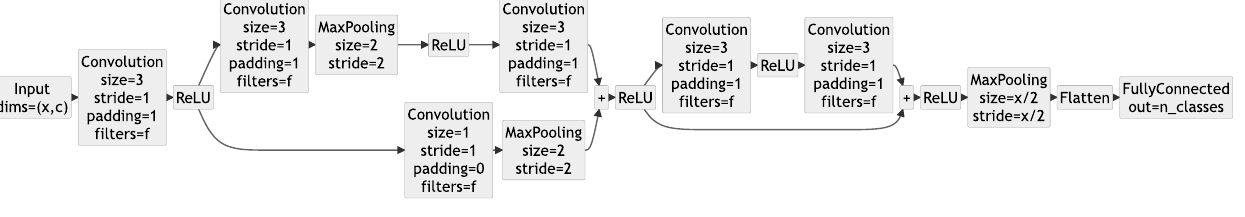
Figure 3. ResNetv1-6 model